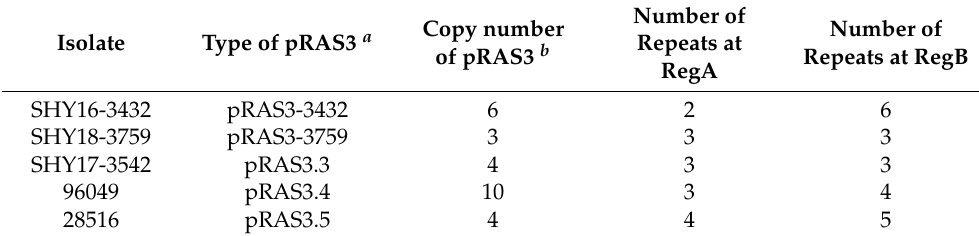
Table 4. Plasmid copy number (PCN) per cell for different pRAS3 plasmids.